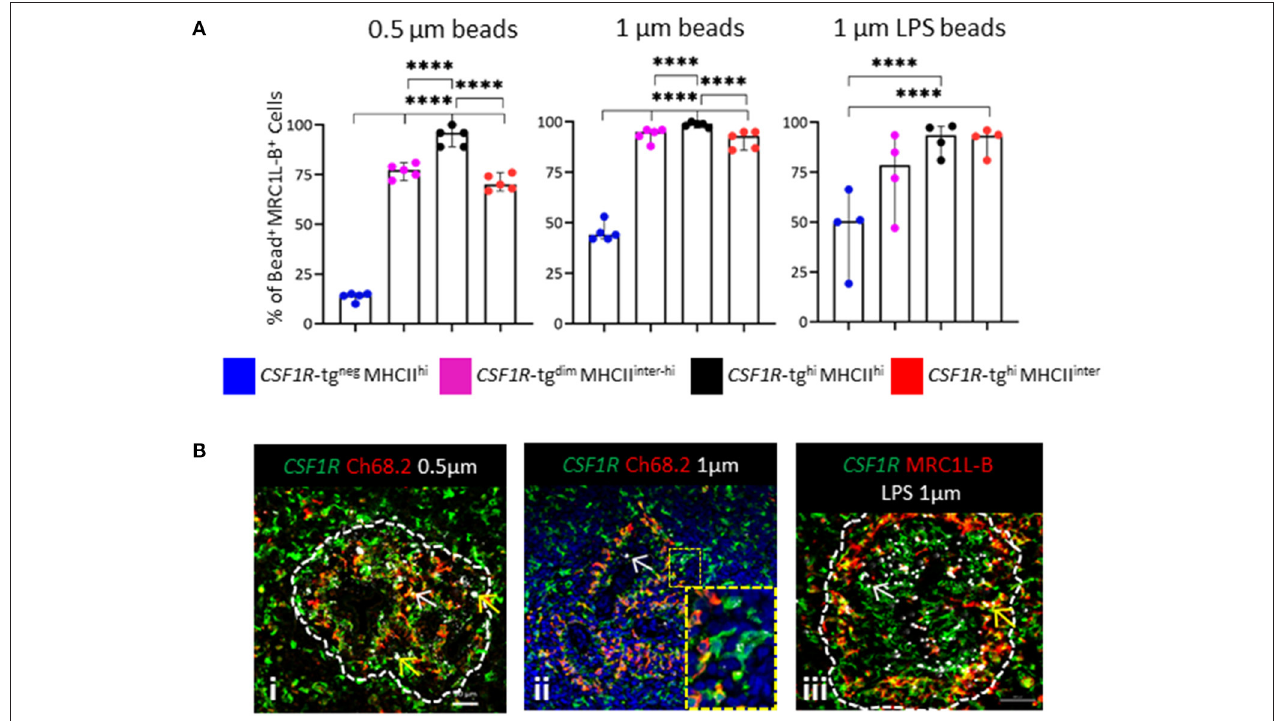
FIGURE 6 | In vivo functional analysis indicates diversity in the EAM. (A) The percentage of MRC1L-B + cells in the 0.5 µ m + , unlabeled and LPS labeled 1 µ m bead + CSF1R -tg + and CSF1R -tg neg subpopulations 3h post-IV bead administration analyzed by flow cytometry. Data is shown as the median of 5 or 4 individual animals and error bars indicate 95% confidence intervals. Asterisks indicate statistical significance ( P < 0.05); (B) histological analysis of the location of the beads in the PWP; (i) few 0.5 µ m beads were located in CSF1R- tg + Ch68.2 + EAC cells (yellow arrow) whereas CSF1R -tg + Ch68.2 neg EAM contain numerous beads (yellow arrow); (ii) the 1 µ m beads co-localize with the CSF1R- tg + Ch68.2 + EAC (white arrow) but numerous beads were found in the CSF1R- tg + Ch68.2 neg EAM (insert image); (iii) LPS labeled 1 µ m beads were located throughout the PWP in CSF1R -tg + MRC1L-B neg EAC (white arrow) while high concentrations of beads were located in